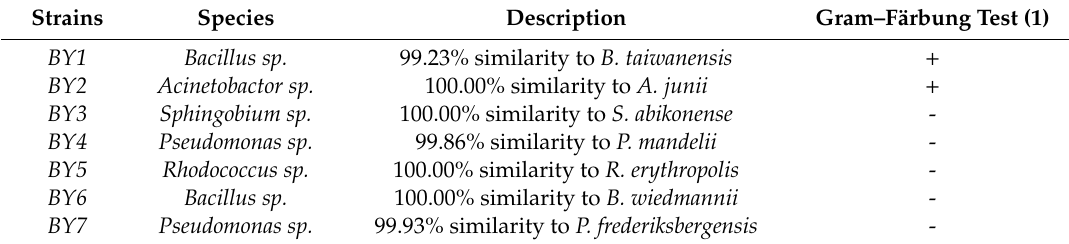
Table 3. Species and Gram–Färbung tests for the isolated strains.